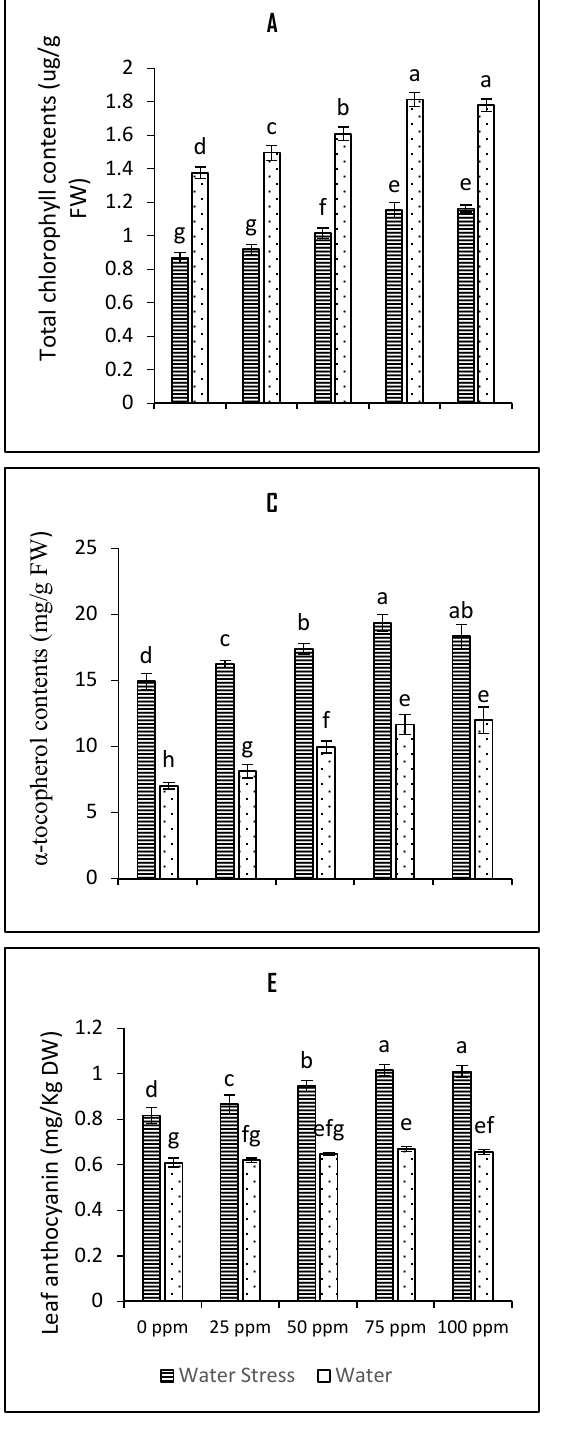
Figure 3. Bar charts (mean ± S.E; n = 3) representing photosynthetic pigments, and assayed antioxi- dant metabolites ( A ) total chlorophyll contents ( B ) leaf total carotenoids ( C ) leaf tocopherol contents ( D ) leaf total flavonoids ( E ) leaf anthocyanin and ( F ) leaf proline contents in tomato plants raised from SeNPs-primed seeds grown under water stress and water conditions. 0, 25, 50, 75, and 100 ppm on x -axis represent concentrations of Se-NPs followed in the seed-priming experiment. Bars with di ff erent alphabets represent mean data which signi fi cantly di ff ers at ( p < 0.05).